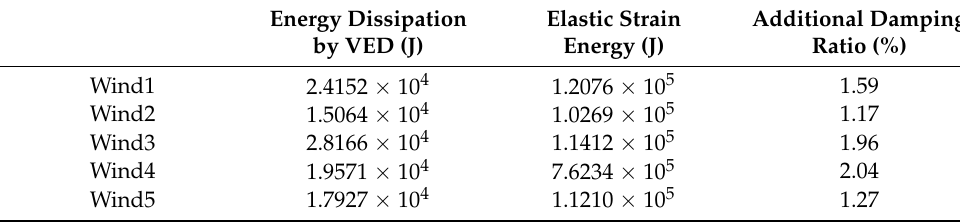
Figure 19. Energy analysis caused by wind-induced vibration: ( a ) energy distribution (VBRB-BF); ( b ) energy absorbed by components (VBRB-BF); ( c ) energy distribution (BRB-BF); and ( d ) energy absorbed by components (BRB-BF). Table 9. Additional damping ratio from VBRB.